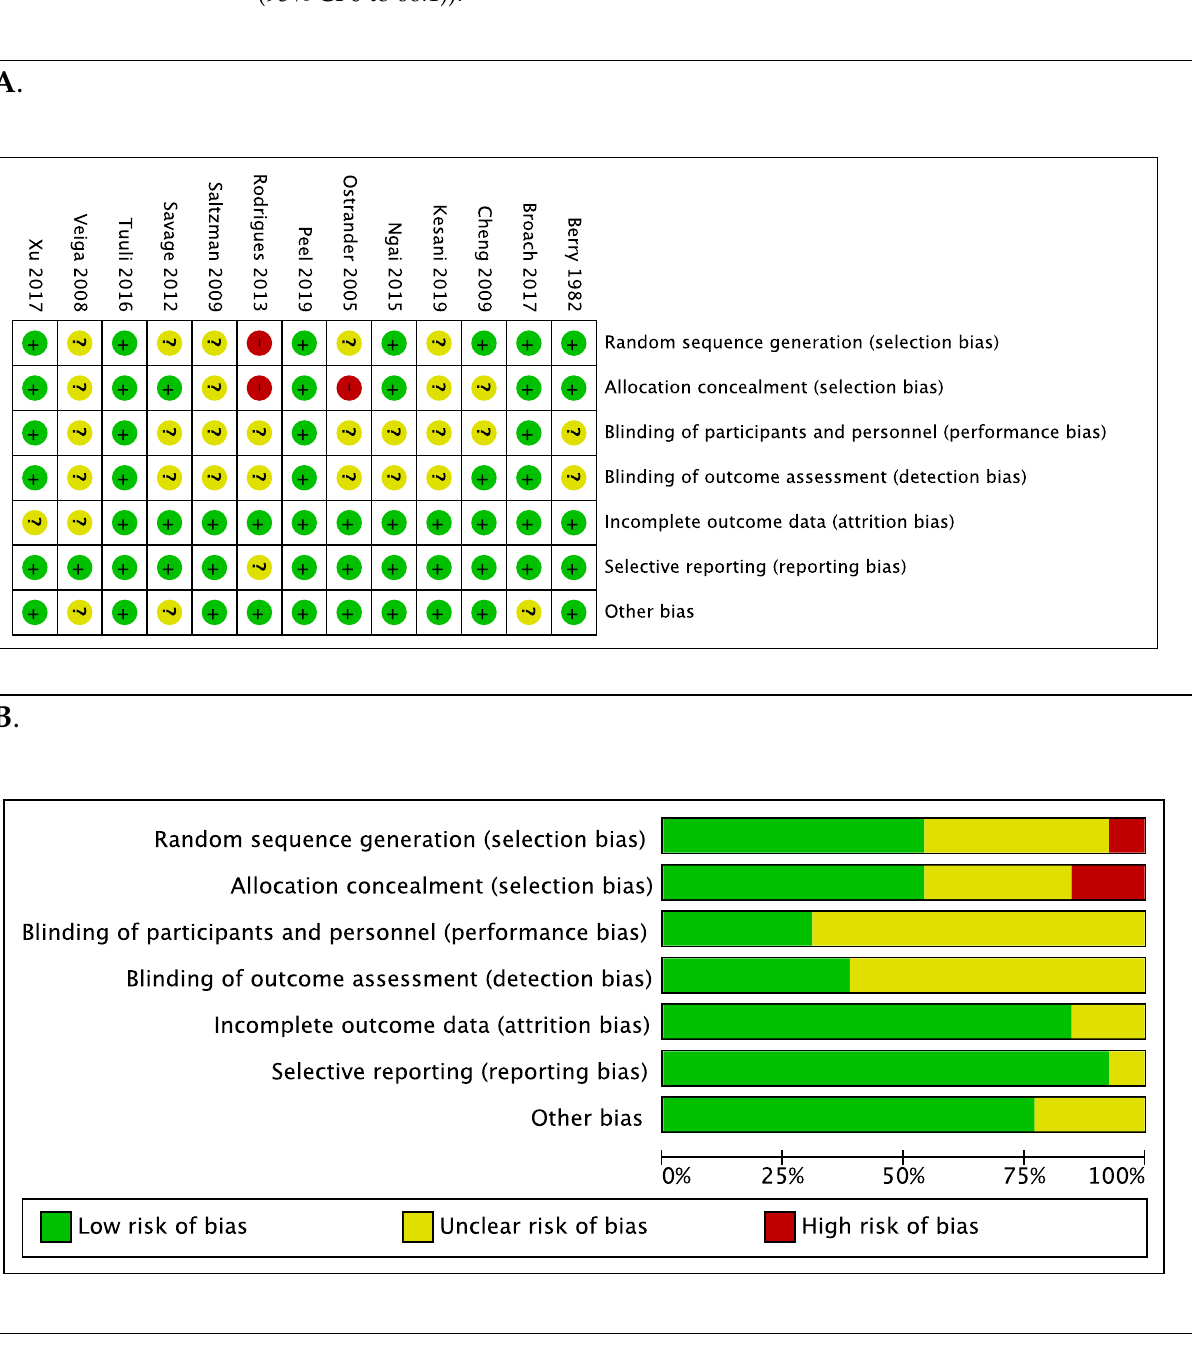
Figure 4 . ( A ). Summary of risk of bias for each trial: low (+), high (−), or unclear (?) and ( B ). Each risk of bias item presented Figure 4. ( A ). Summary of risk of bias for each trial: low (+), high ( − ), or unclear (?) and ( B ). Each risk of bias item presented as percentages across all included studies. as percentages across all included